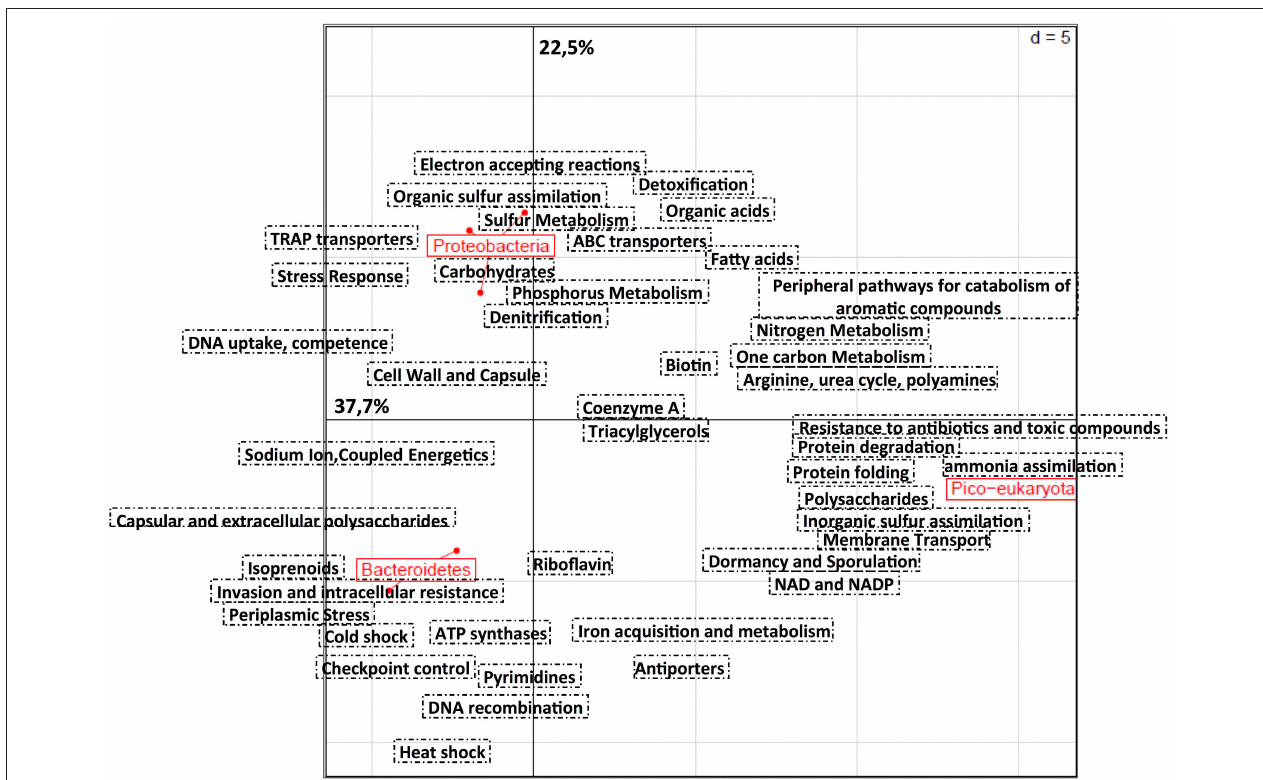
FIGURE 3 | Principal component analysis based on the relative distribution of 105 functional subsystems in seven draft genomes recovered from the ASP. Annotation was done using RAST ( Aziz et al., 2008). The analysis was performed using R software and the Ade4TkGUI package (Thioulouse et al., 1997). Proteobacteria includes Oceanospirillaceae ASP10-02a, SAR92 ASP10-03a, and Rhodobacteraceae ASP10-04a. Bacteroidetes includes Cryomorphaceae ASP10-05a, Polaribacter ASP10-06a, and Flavobacteriaceae ASP10-09a. Finally, Micromonas ASP10-1a is the only pico-eukaryota